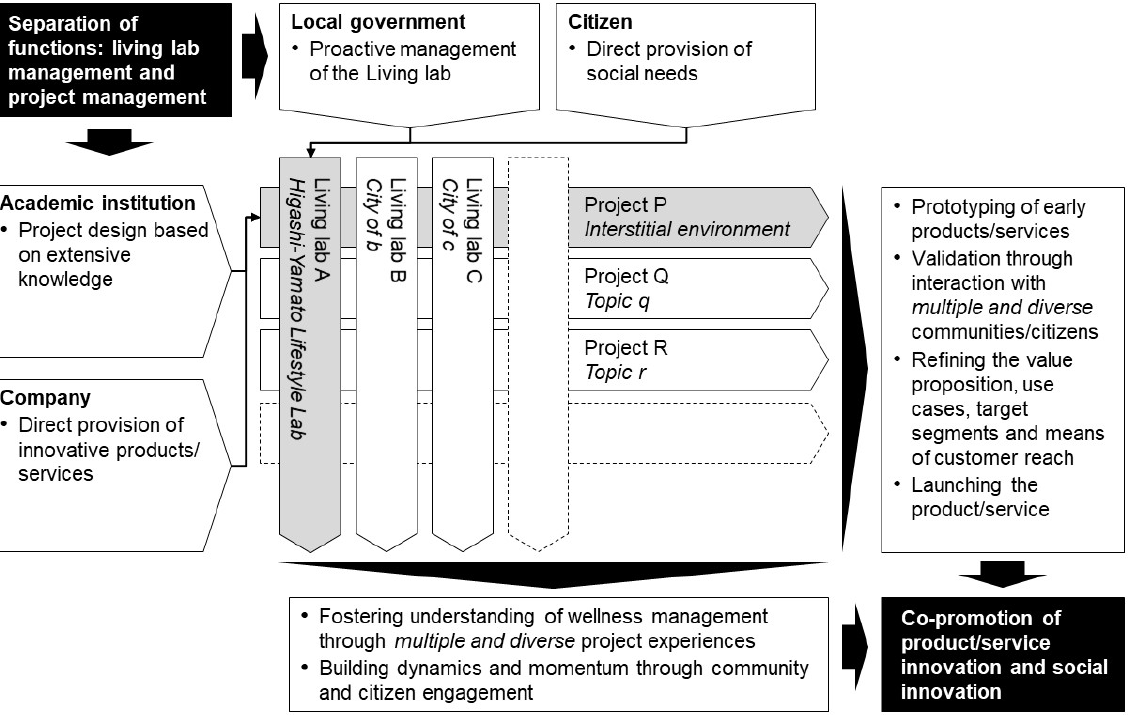
Figure 6. Programme design consisting of multiple projects and living labs. Shaded areas indicate the present case, and blank areas indicate generalised ones.